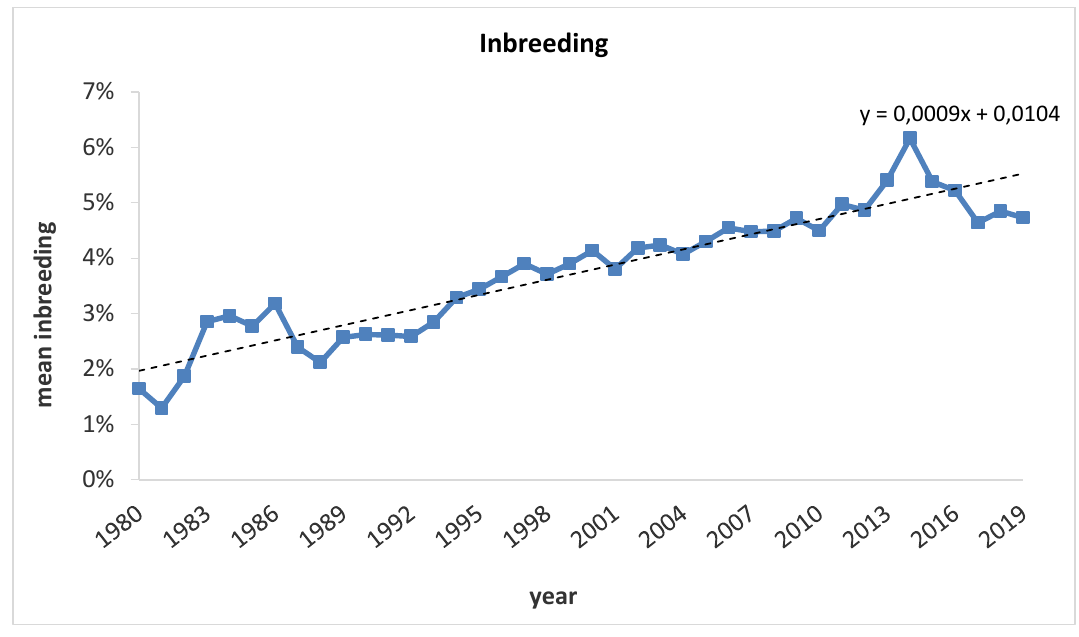
Figure 3. Average inbreeding per year for each Maremmano horse here analyzed.